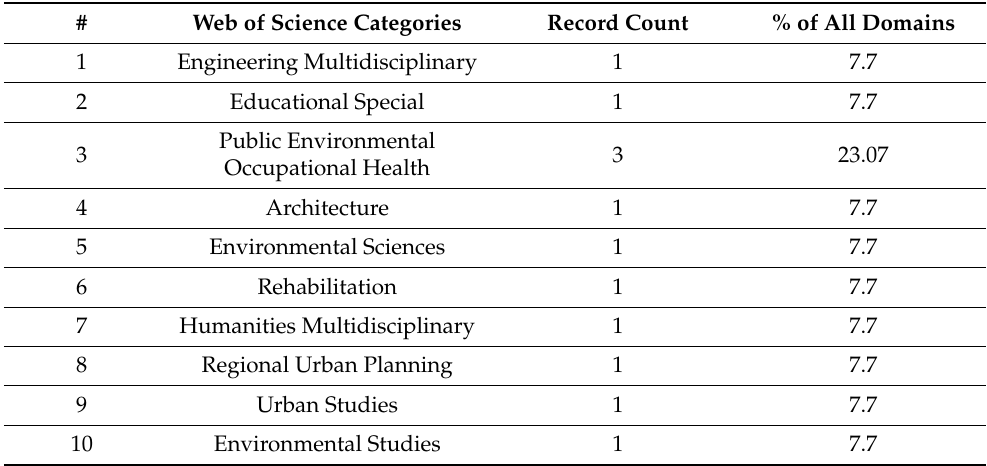
Table 1. WoS categories (some articles belong to more than one category; see, for example, the Public Environmental Occupational Health